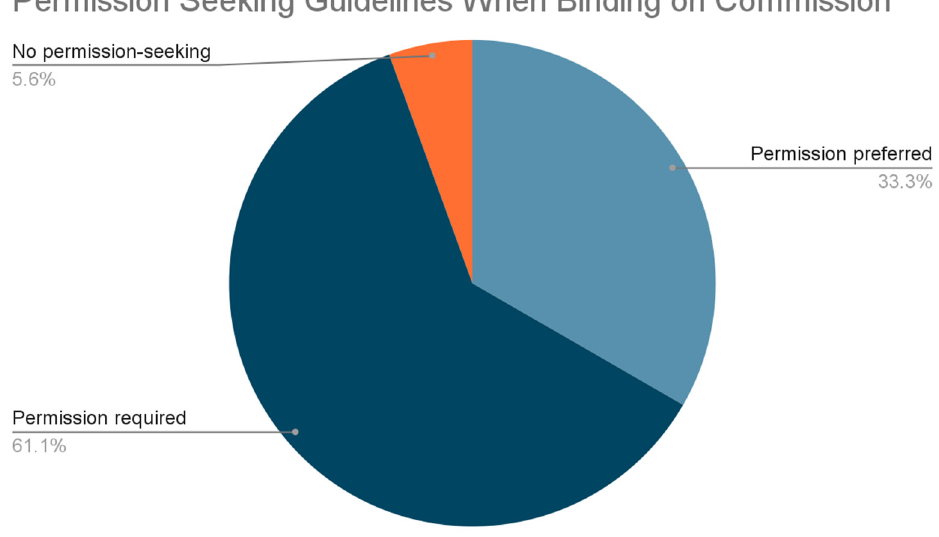
Figure 2. Permission Seeking Guidelines When Binding on Commission.